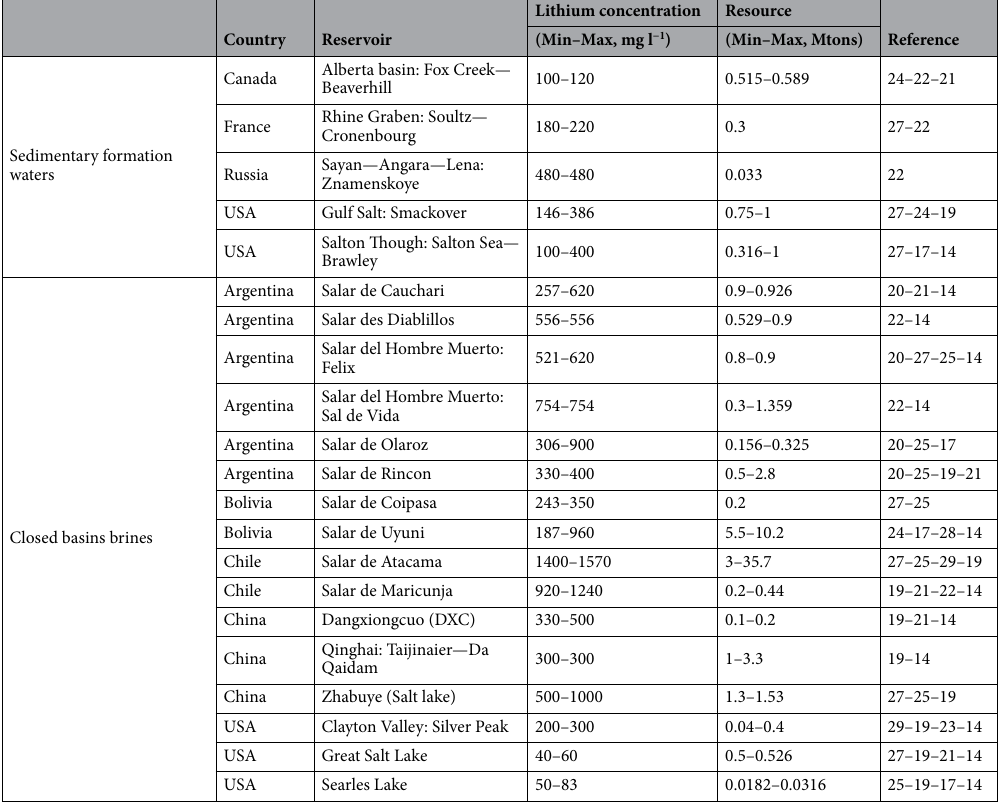
Table 3. Lithium concentrations and lithium resources compiled from published sources of hard-rock deposits, sedimentary formation waters and closed basin